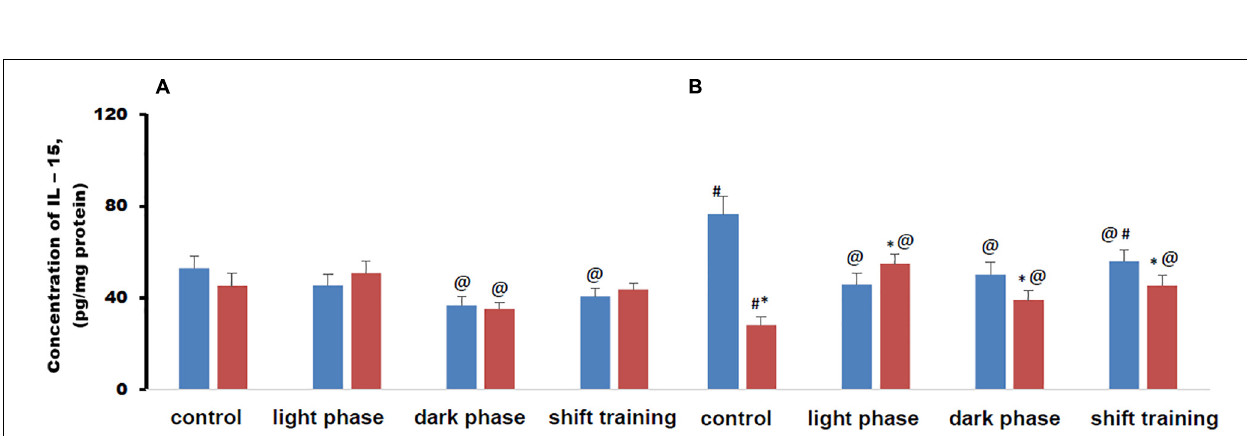
Frontiers in Physiology |